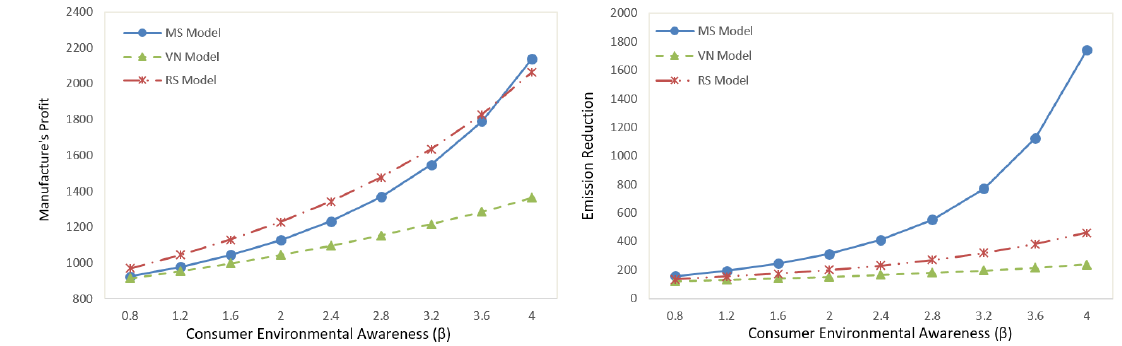
Figure 3. Impact of the consumer environmental awareness on the ( left ) manufacturer’s profits and ( right ) emission reduction in different power structures.